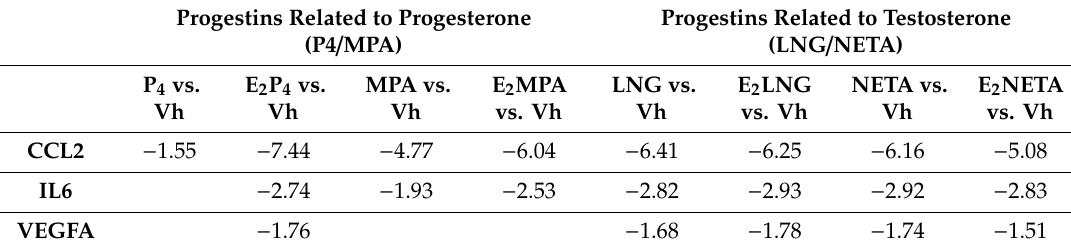
Table 6. Fold change of common DEG in all progestins in absence or presence of E 2 . E 2 : estradiol; P 4 : progesterone; MPA: medroxyprogesterone acetate; LNG: levonorgestrel; NETA: norethindrone acetate; Vh: vehicle.